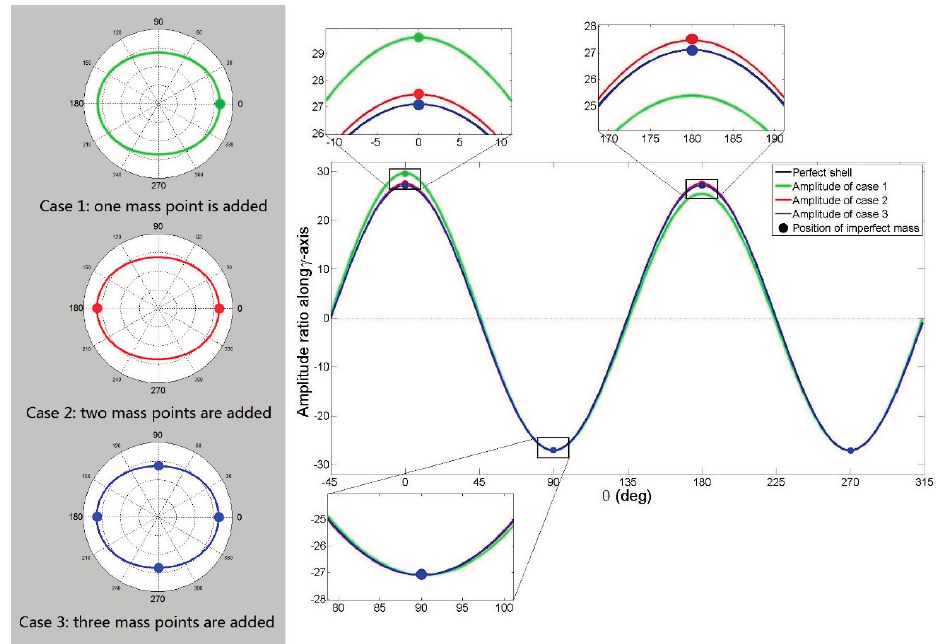
Figure 8. The mode shape of the perfect and imperfect resonator (the amplitude ratio is along the γ -axis at the resonators’ bottom, negative amplitudes represent the phase difference of π